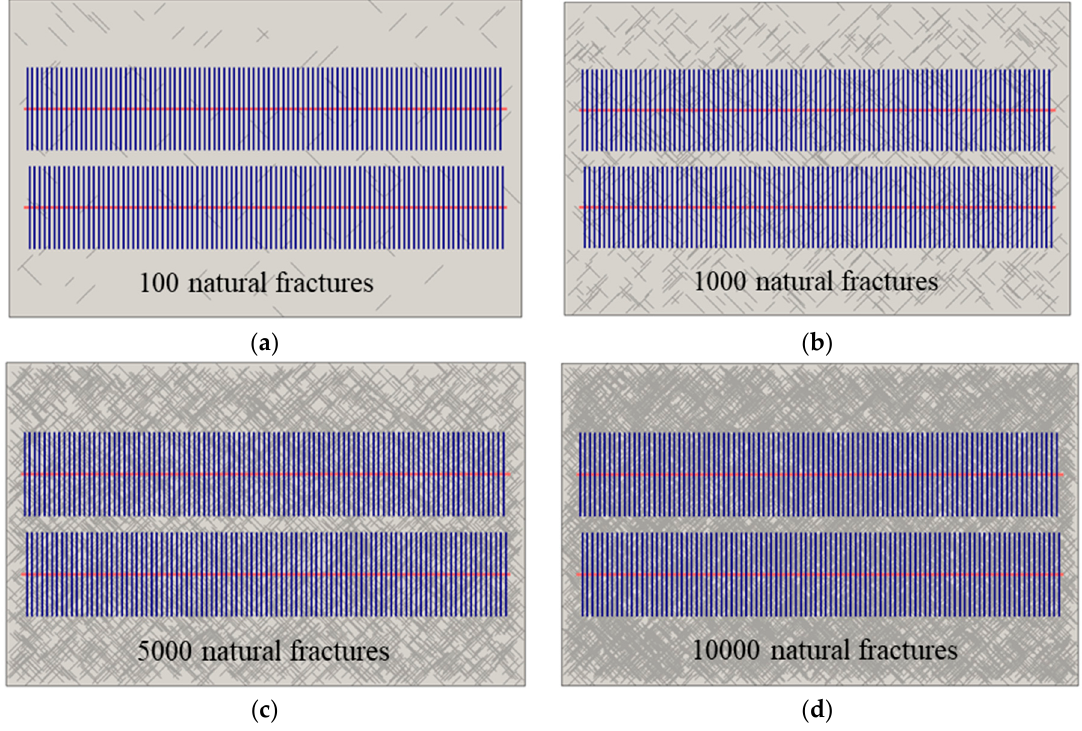
Figure 7. The basic reservoir simulation model including two horizontal wells with well spacing of 300 m and four different numbers of natural fractures: ( a ) 100 natural fractures; ( b ) 1000 natural fractures; ( c ) 5000 natural fractures; ( d ) 10,000 natural fractures.